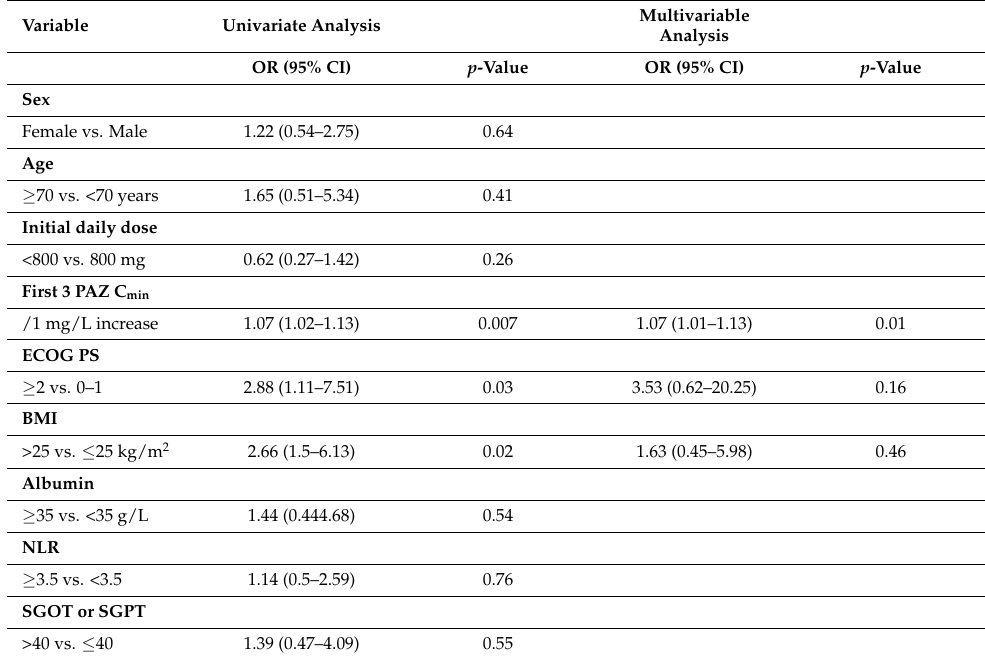
Table 4. Univariate and multivariable logistic regression models of risk factors for dose-limiting toxicities (n =